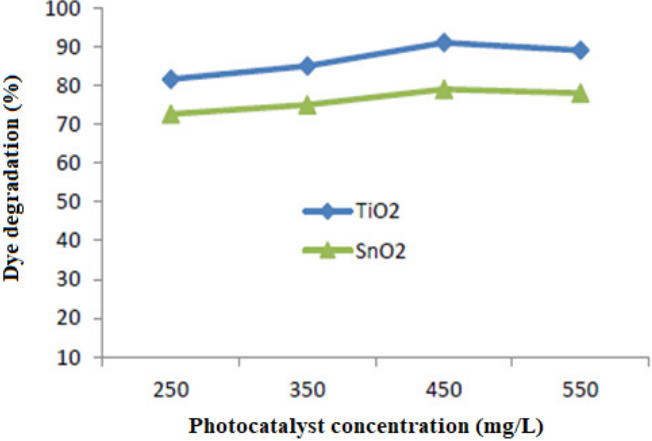
Figure 5. Effect of catalysts (TiO 2 , SnO 2 ) dose on the degradation of dye Reactive Yellow 160A (RY-160A = 30 mg/L, H 2 O 2 = 0.8 mL).